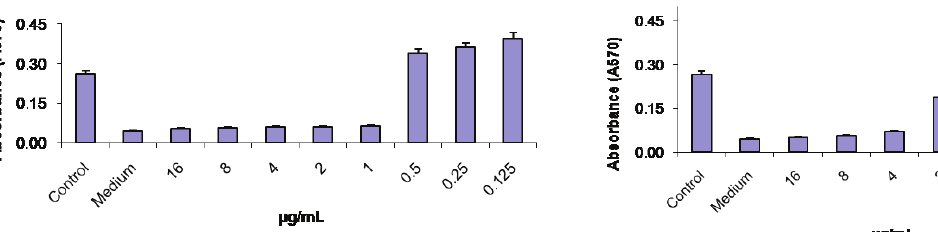
Figure 2. Cytotoxic effect of Macrovipera lebetina lebetina crude venom on L929 cells after 48-hour exposure to different venom concentrations. Cell viability was determined by MTT assay, control was exposed to vehicle only which was taken as 100% viability. Data are expressed as mean ± SD.